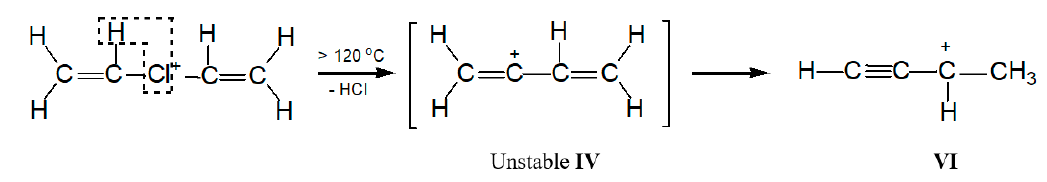
Figure 12. IR spectra in transmittance of the protium ‐ (red) and deuterium ‐ (blue) C 4 H 5+ carbocation in their salts with the {Cl 11 − } anion in the frequency range of CH stretches ( a ) and below 1600 cm − 1 ( b ). The intensities of both spectra are reduced to unit anion intensity.